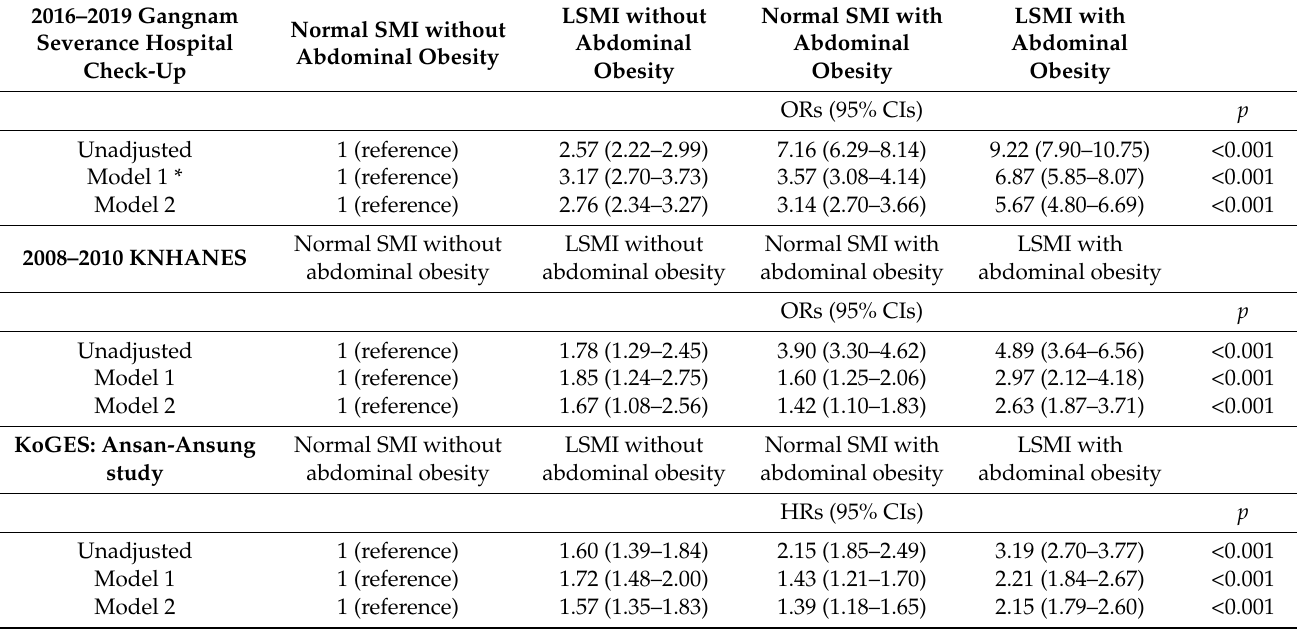
Table 3. Relationship between NAFLD and LSMI status with or without abdominal obesity.